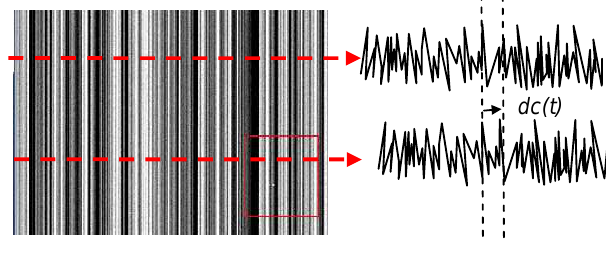
Figure 12 : “Steady-mode” image